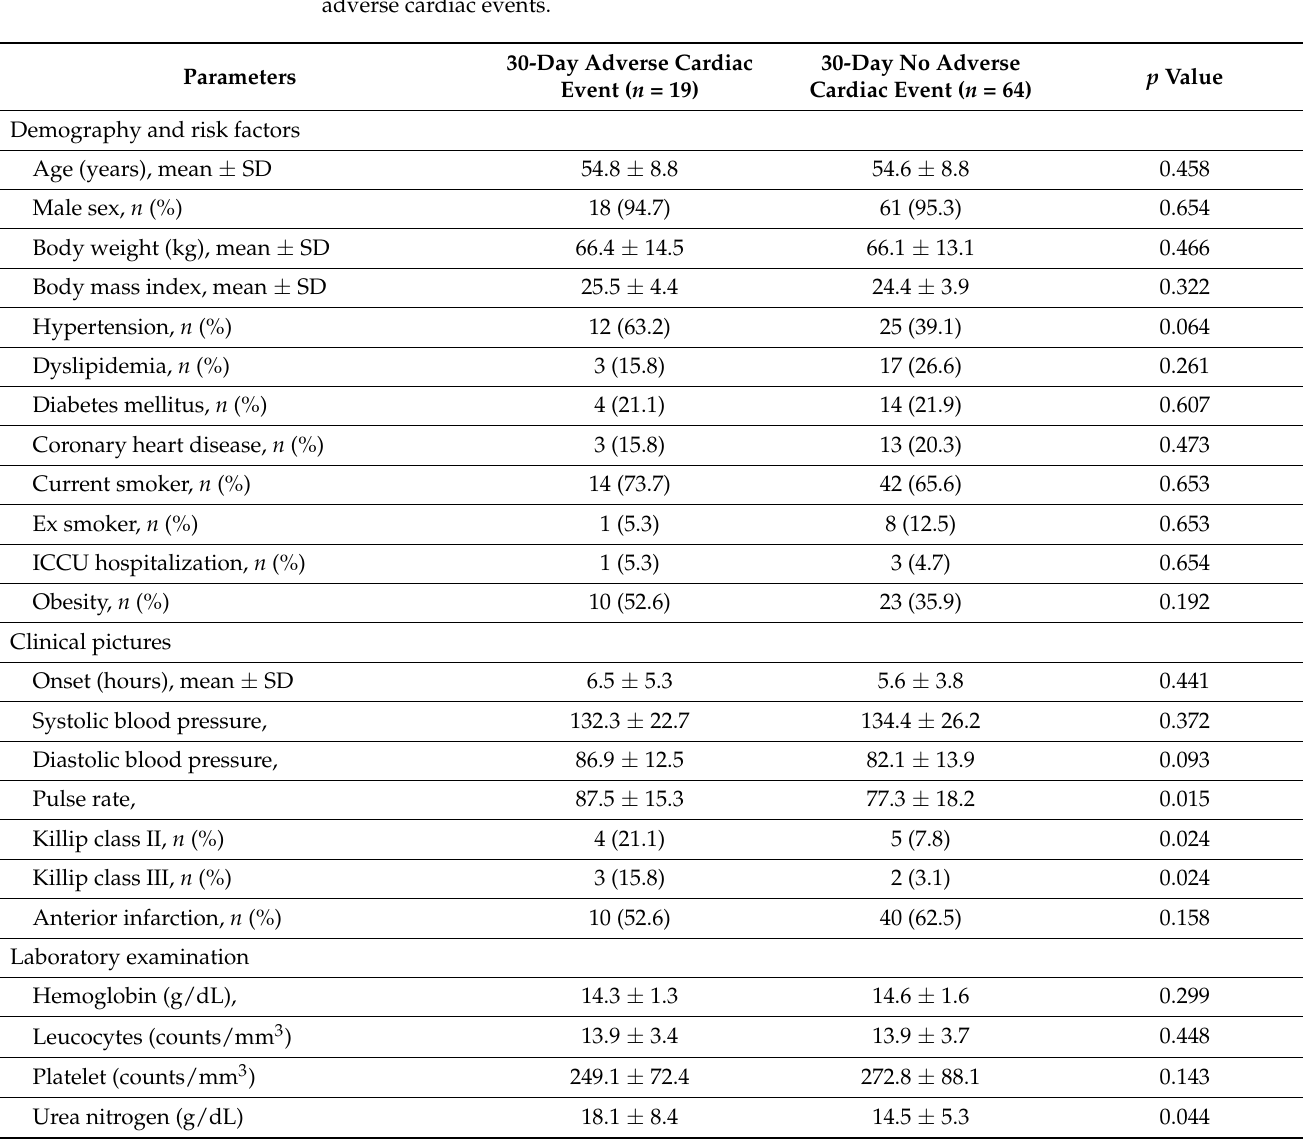
Table 3. The characteristics of subjects divided by the presence and the absence of 30-day follow up adverse cardiac